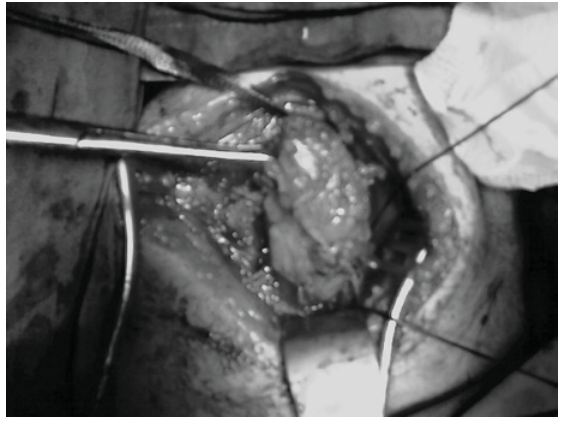
Figure 3. Intraoperative view of the carotid body tumor